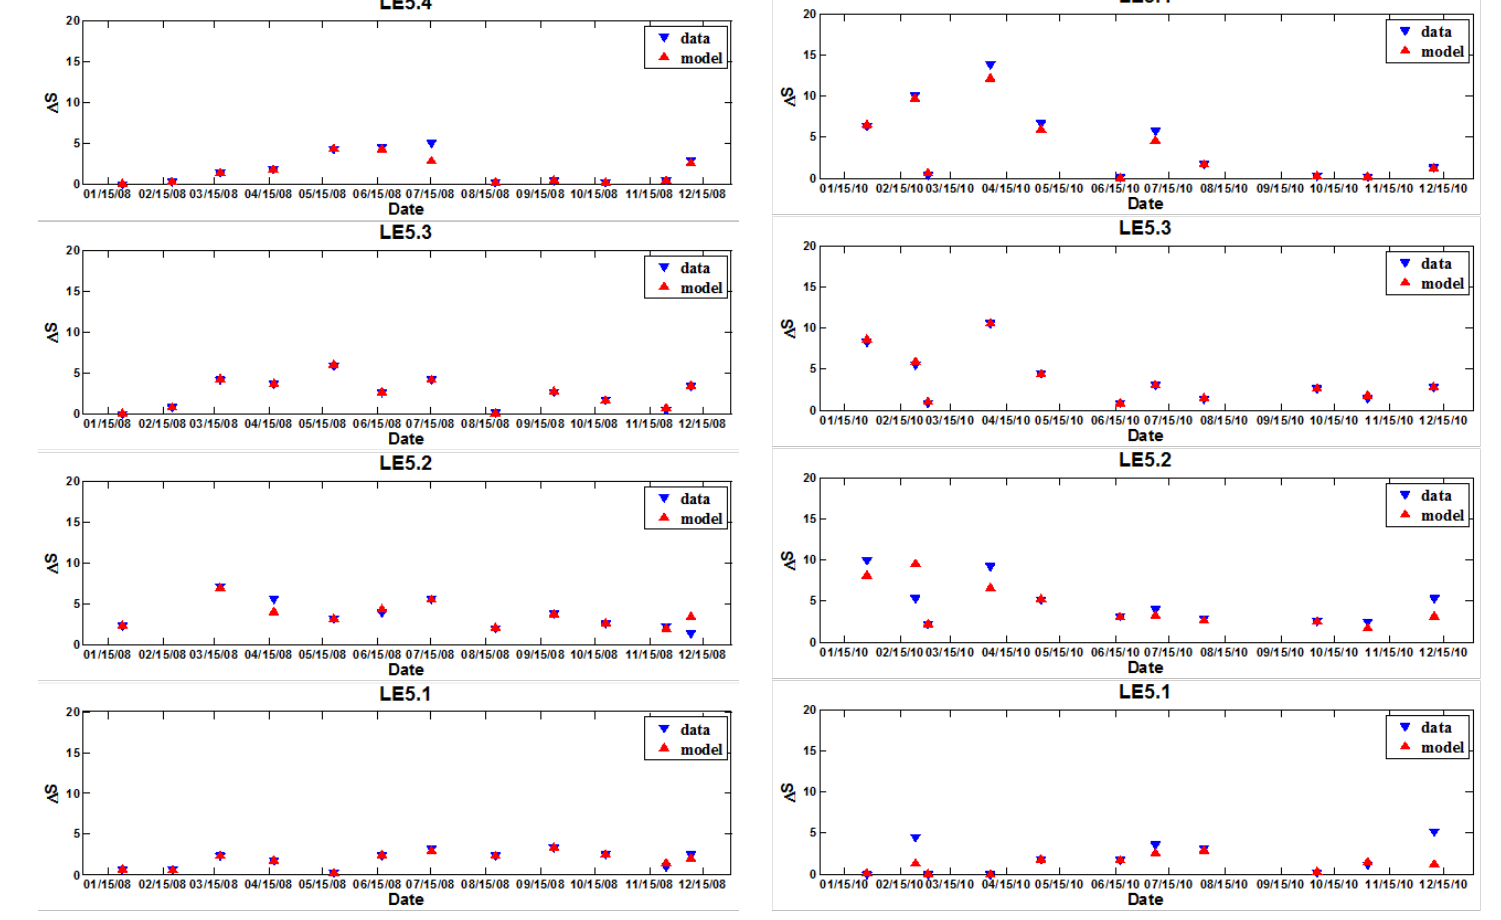
Figure 5. Comparison stratification.